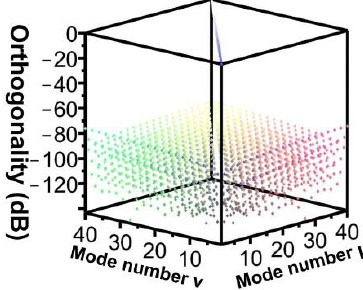
Figure 5. Orthogonal relationship among 40 modes.